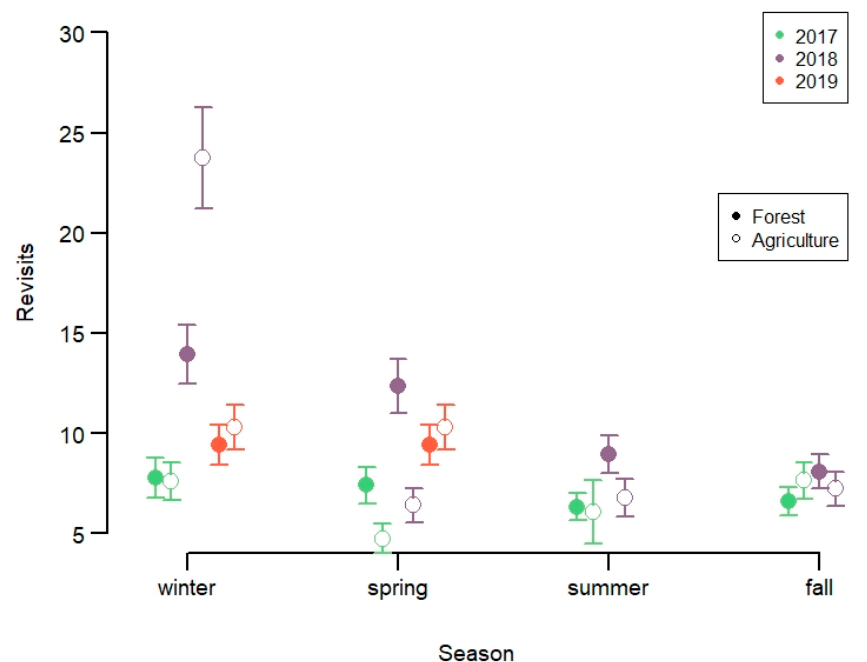
Figure 5. Number of GPS-positions per spatial cluster of marked red deer in Lærdal municipality, Norway. Note that minimum number of revisits was 5 as of definition.